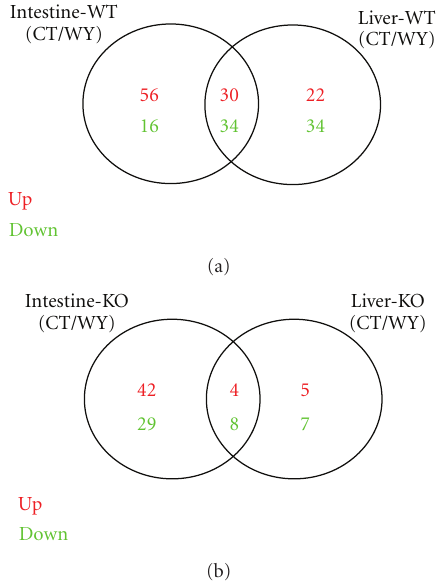
Figure 4: Comparison of PPAR α -independent or WY14643- dependent regulated pathways between in small intestine and liver of mice. Venn diagram showing the overlapping significantly identified pathways by the comparison of PPAR α -independent or WY14643-dependent regulated pathways between in small intestine and liver of mice. The studies of Intestine-WT (CT/WY) and Liver- WT (CT/WY) are for identifying WY14643-dependent pathways; the studies of Intestine-KO (CT/WY) and Liver-KO (CT/WY) are for identifying PPAR α -independent pathways, respectively, in mice small intestine and liver. Pathways of P value less than 0.01 were considered to be significantly regulated. Red color is for upregulated pathways and green color is for downregulated pathways. In (a), there were 30 upregulated and 34 downregulated WY14643-dependent pathways in common; in (b), there were only 4 upregulated and 8 downregulated PPAR α -independent pathways in common in both tissues of